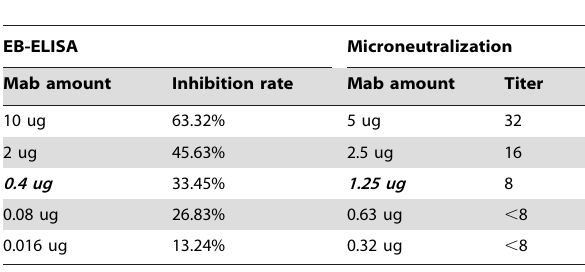
Table 3. The detection limit of EB-ELISA and microneutralization assay.